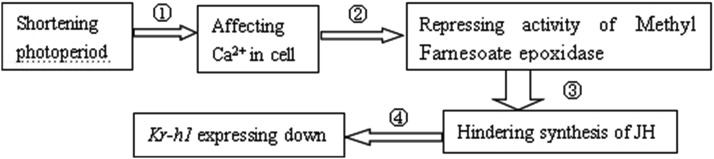
Molecular mechanism of photoperiod affecting Kr-h1 gene expression Supporting data: ①: KEGG pathway id: ko04745 from fly; ②–③ Huang et al. 1994 from Gryllus bimaculatus; ④: Jindra et al. 2013 from many insects; Jindra et al. 2015 from many insects.